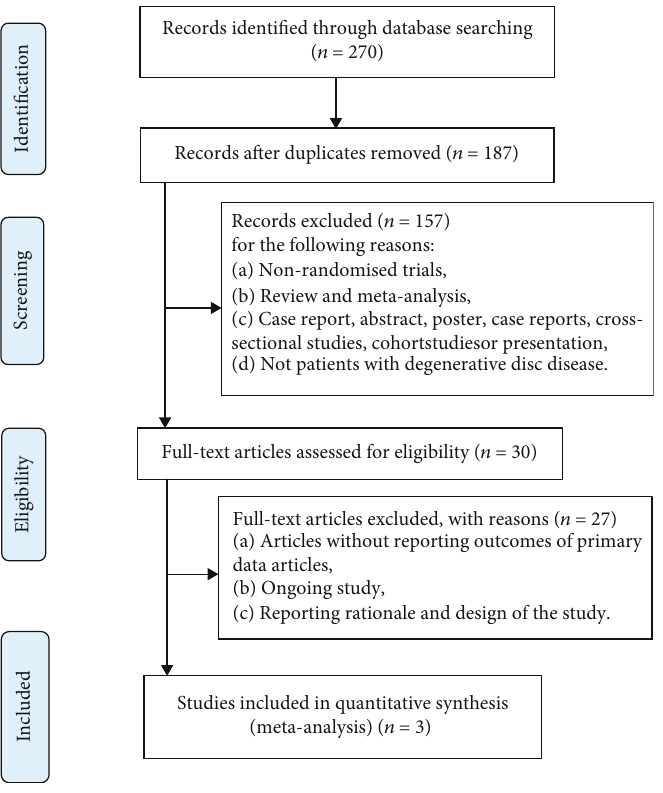
Figure 1: Flowchart of the retrieval